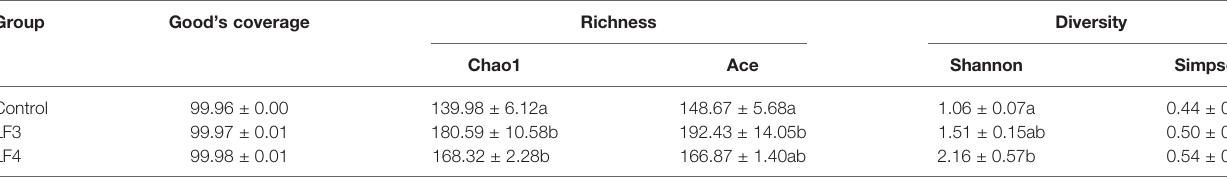
TABLE 1 | Alpha diversity indexes of intestial microbiota of Japanese seabass, L. japonicus . Group